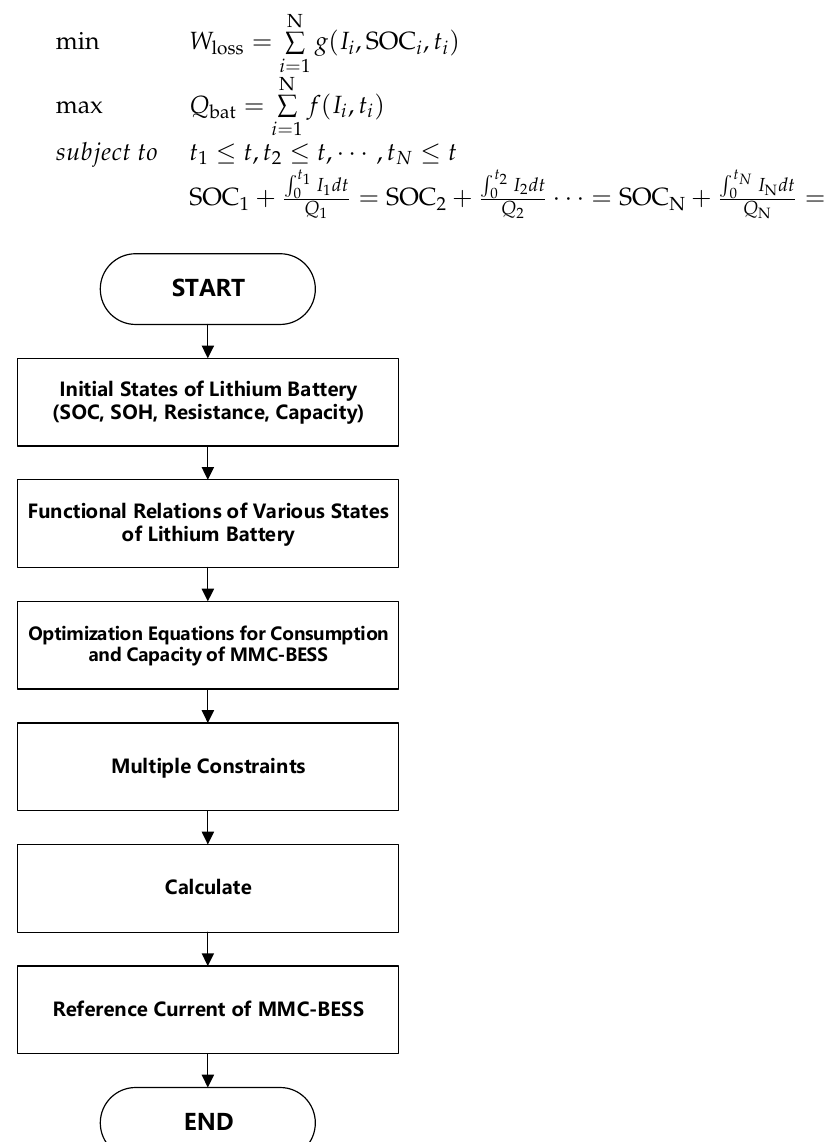
Figure 9. Flow chart to calculate reference current of MMC-BESS.